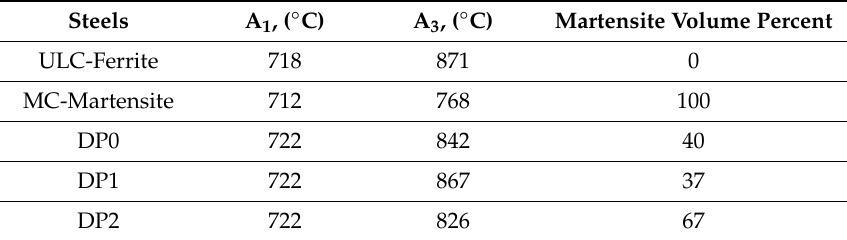
Table 3. Equilibrium temperatures ( ◦